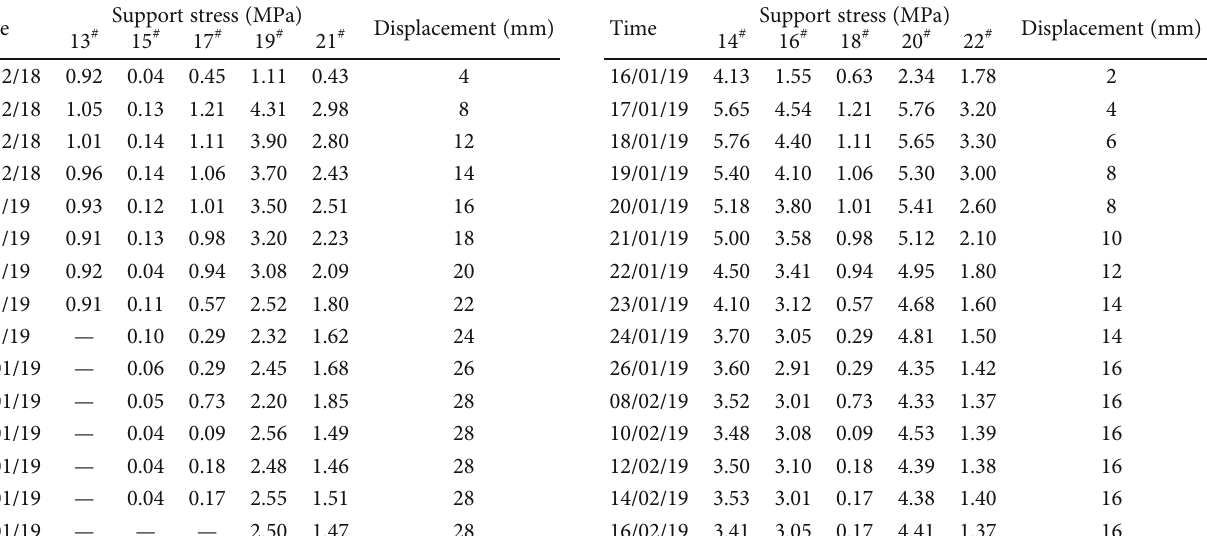
Table 9: Monitoring results: support stress and displacement of Section II